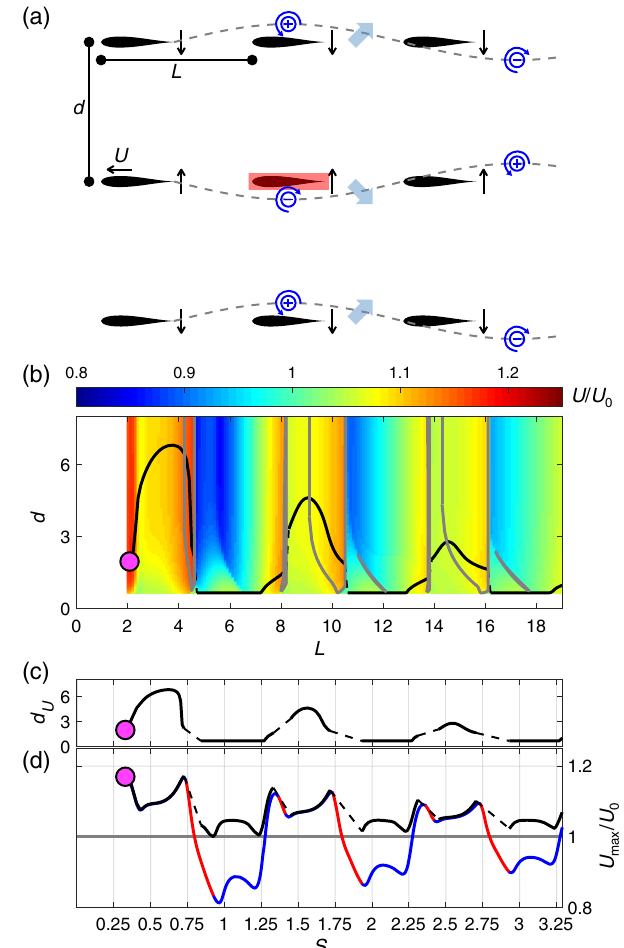
FIG. 5. Speed-up in a rectangular lattice. (a) Schematic of the rectangular lattice of swimmers that maximizes the speed-up U =U 0 . This state has U =U 0 ¼ 1 . 18 for L ¼ 2 . 1 and av av d ¼ 1 . 94 , corresponding to S ¼ 0 . 33 , and is indicated by the pink dot in (b) – (d). The formation ’ s dynamics is determined by that of the swimmer at the origin (red box), and black arrows indicate the swimmers ’ instantaneous vertical velocity. Dashed lines indicate the trajectories of the swimmers in the upstream column, with associated vortices (blue) and fluid flows (thick blue arrows). (b) The color map shows the normalized time- =U 0 as a function of L and d , based on averaged speed U av numerical simulations of rectangular lattice formations. The L Þ indicates the optimal lateral spacing as a black curve d U ð function of the streamwise spacing L . Multiple coexisting states, obtained by changing the initial conditions, are found in the regions bounded by the gray curves. (c) Optimal lateral spacing d L Þ plotted as a function of the schooling number S . (d) The U ð =U 0 (black), superimposed on top of associated speed-up U max the results for an in-line formation from Fig. 3(b). The dashed portions of the black curves in (b) – (d) are guides to the